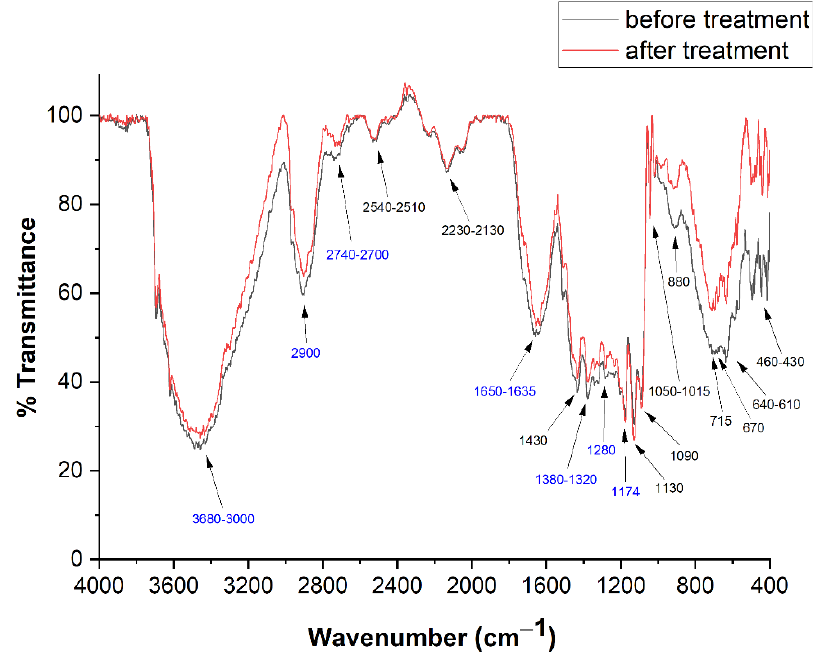
Figure 5. FTIR spectra before (black) and after (red) deacidification treatment recorded from page 1. Frequency values in blue are identified as cellulose peaks. Table 1. FTIR wavenumbers, vibrational mode and related chemical compounds (cellulose bands are in blue) (Miller and Wilkins 1952; Garside and Wyeth 2003; Sequeira et al., 2006; Librando et al., 2011). Wavenumber (cm − 1 )